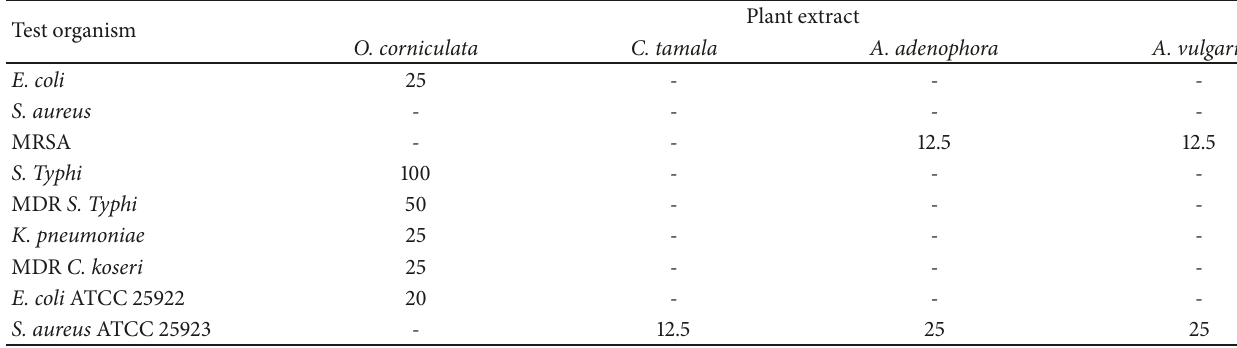
Table 4: MIC value of plant extracts against microorganisms (mg/mL). Test